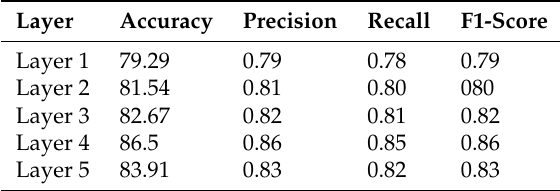
Table 7. CNN-Results-Physionet.